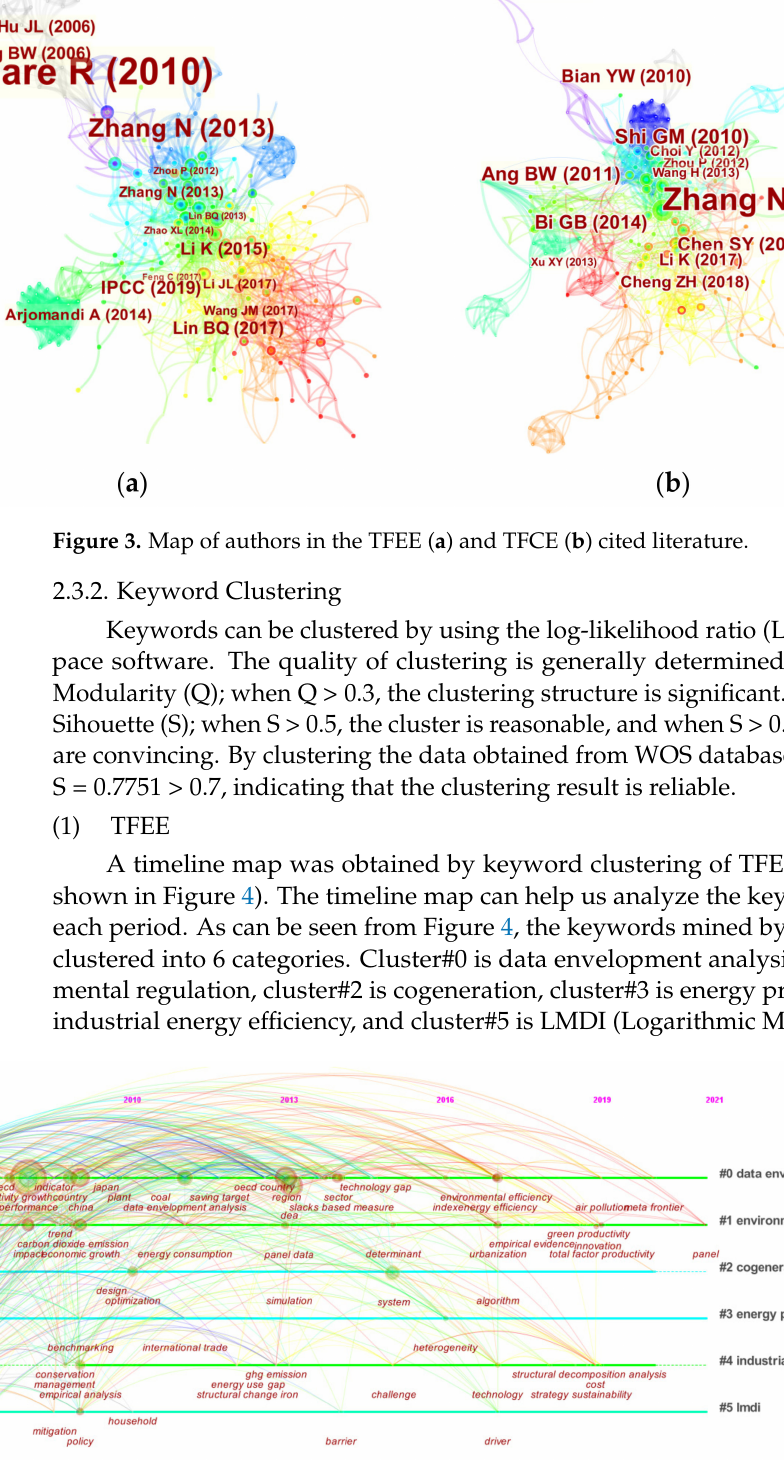
Figure 4. Timeline map of TFEE keyword